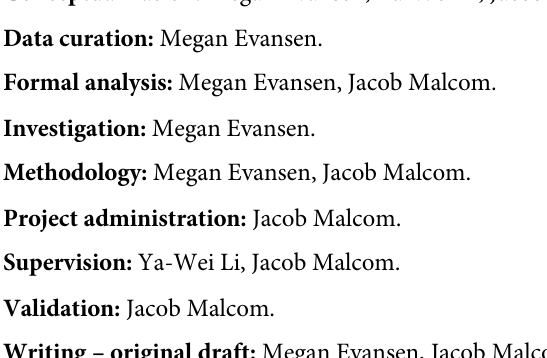
S1 Fig. Informal sticker